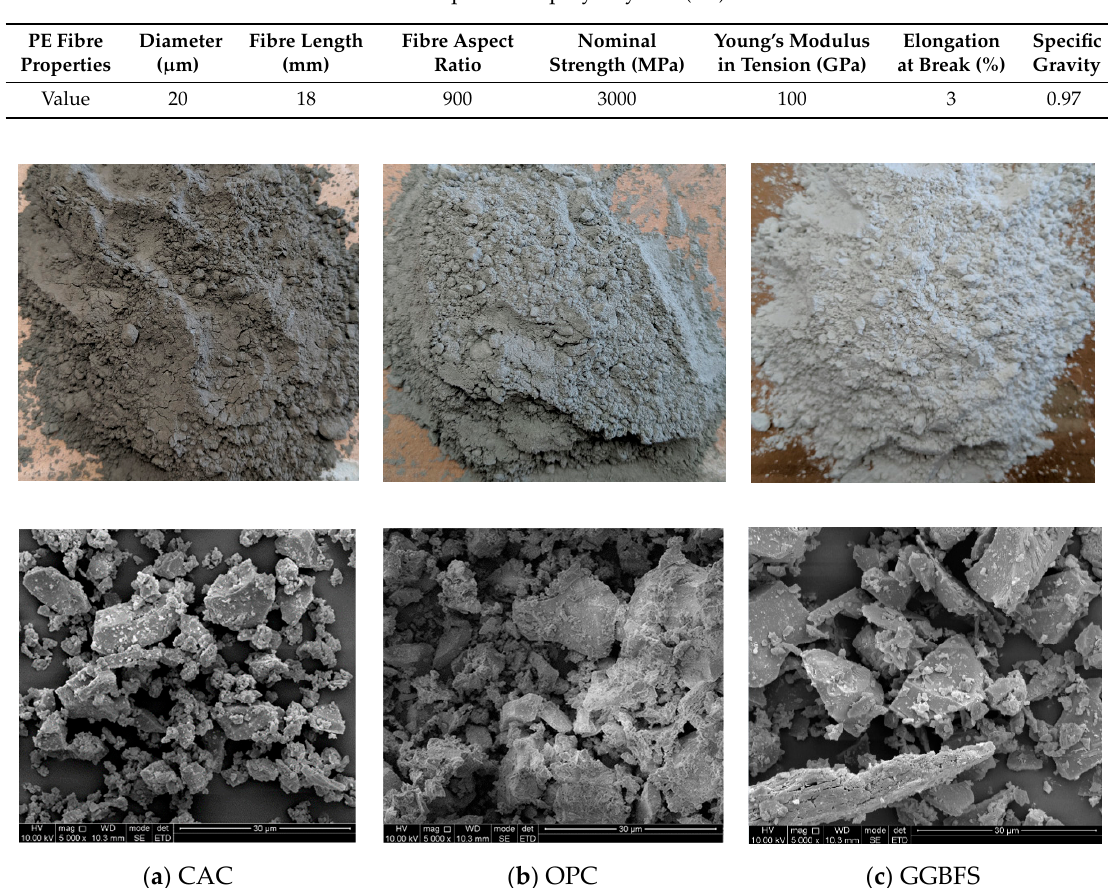
Figure 1. Photo ( a ) and SEM image ( b ) of polyethylene (PE) fibre. Table 1. Properties of polyethylene (PE) fibre.